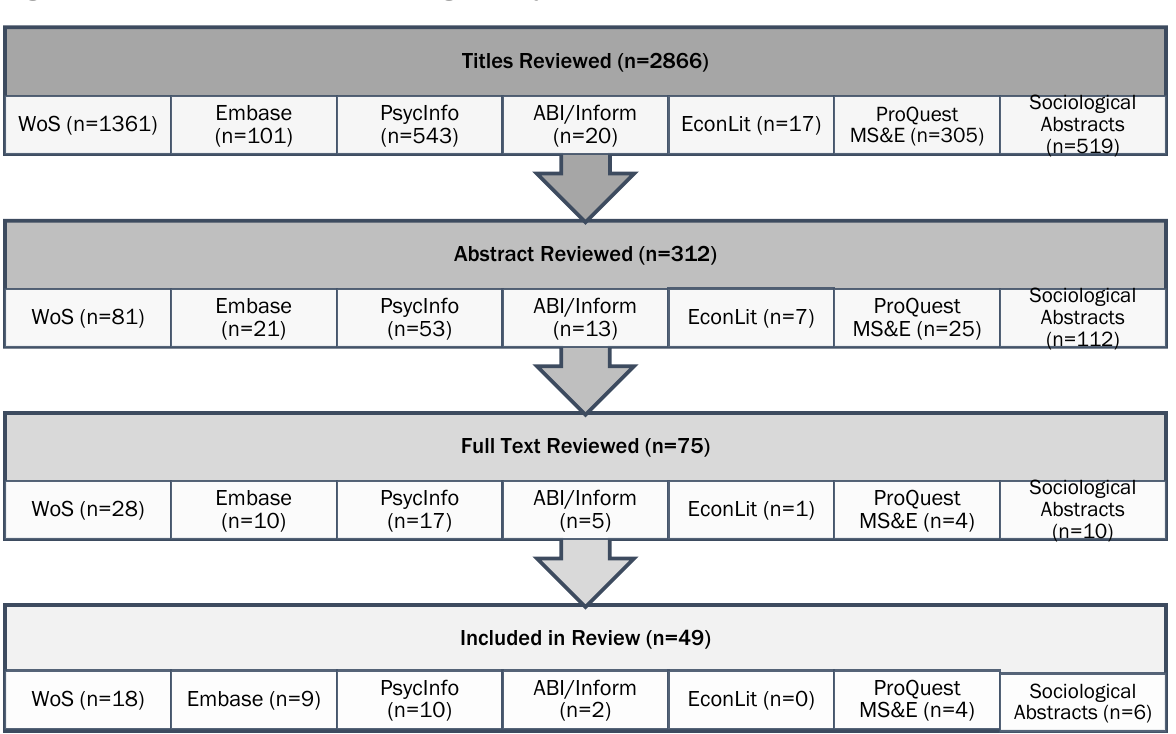
Figure 1. Flow Chart of Articles Resulting from Systematic Review